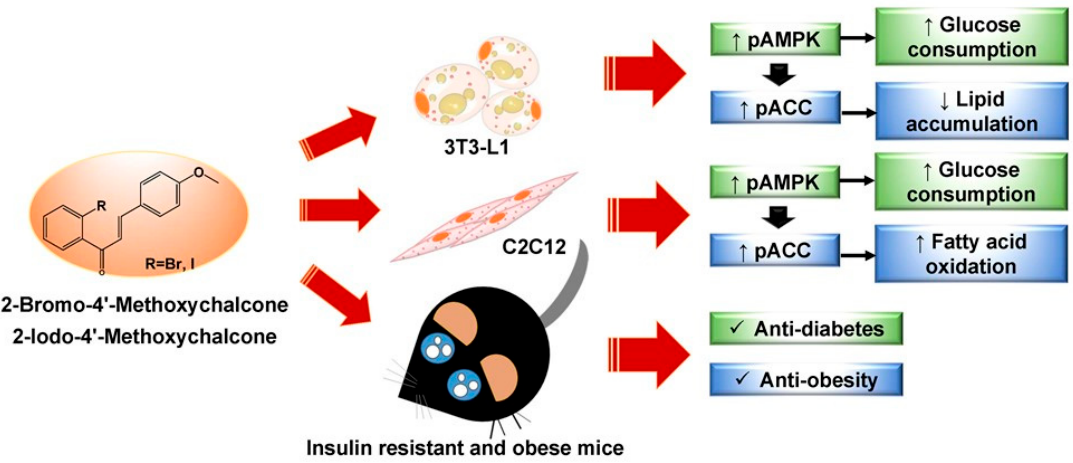
Figure 8. Summary of the antidiabetic and anti-obesity effects of 2-bromo-4 ′ -methoxychalcone and 2-iodo-4 ′ -methoxychalcone.